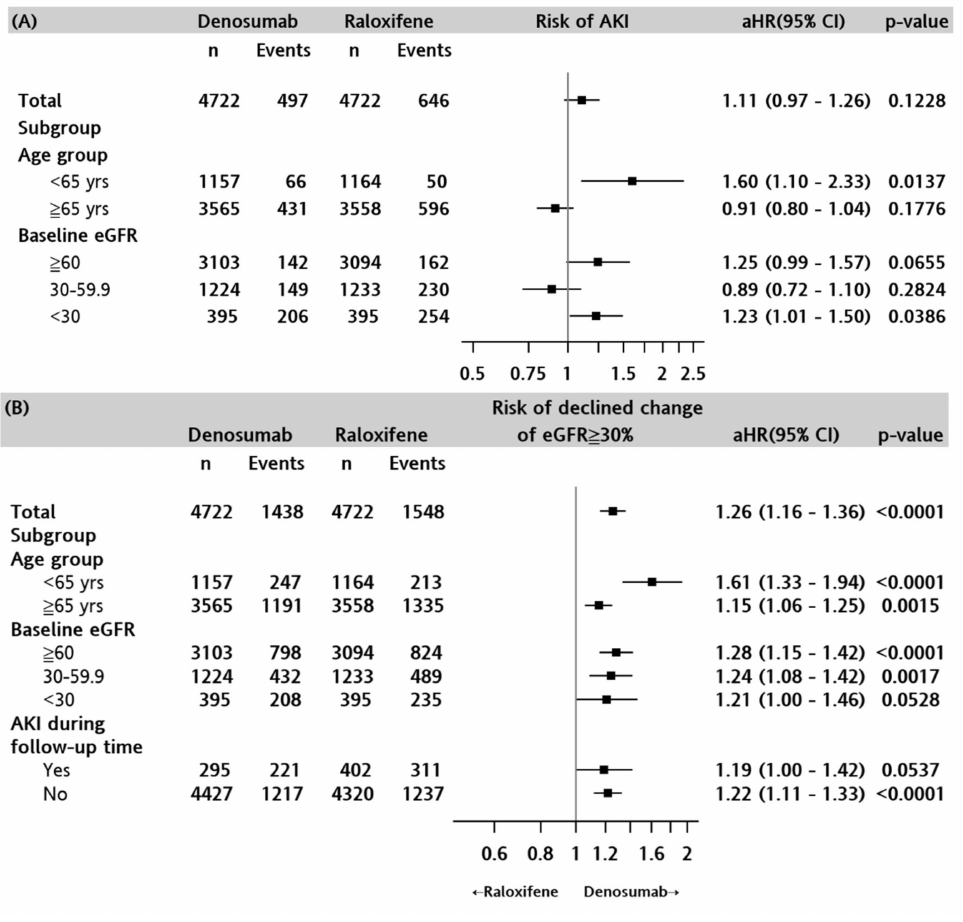
Figure 3. Cox regression model of ( A ) AKI and ( B ) eGFR decline ≥ 30% from baseline between denosumab and raloxifene groups. AKI: Acute kidney injury; aHR: adjusted hazard